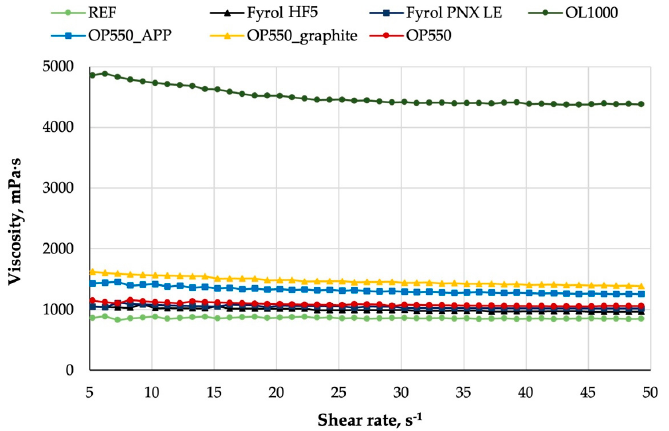
Figure 1. Viscosity curves for a mixture of polyols and polyols with flame retardants.